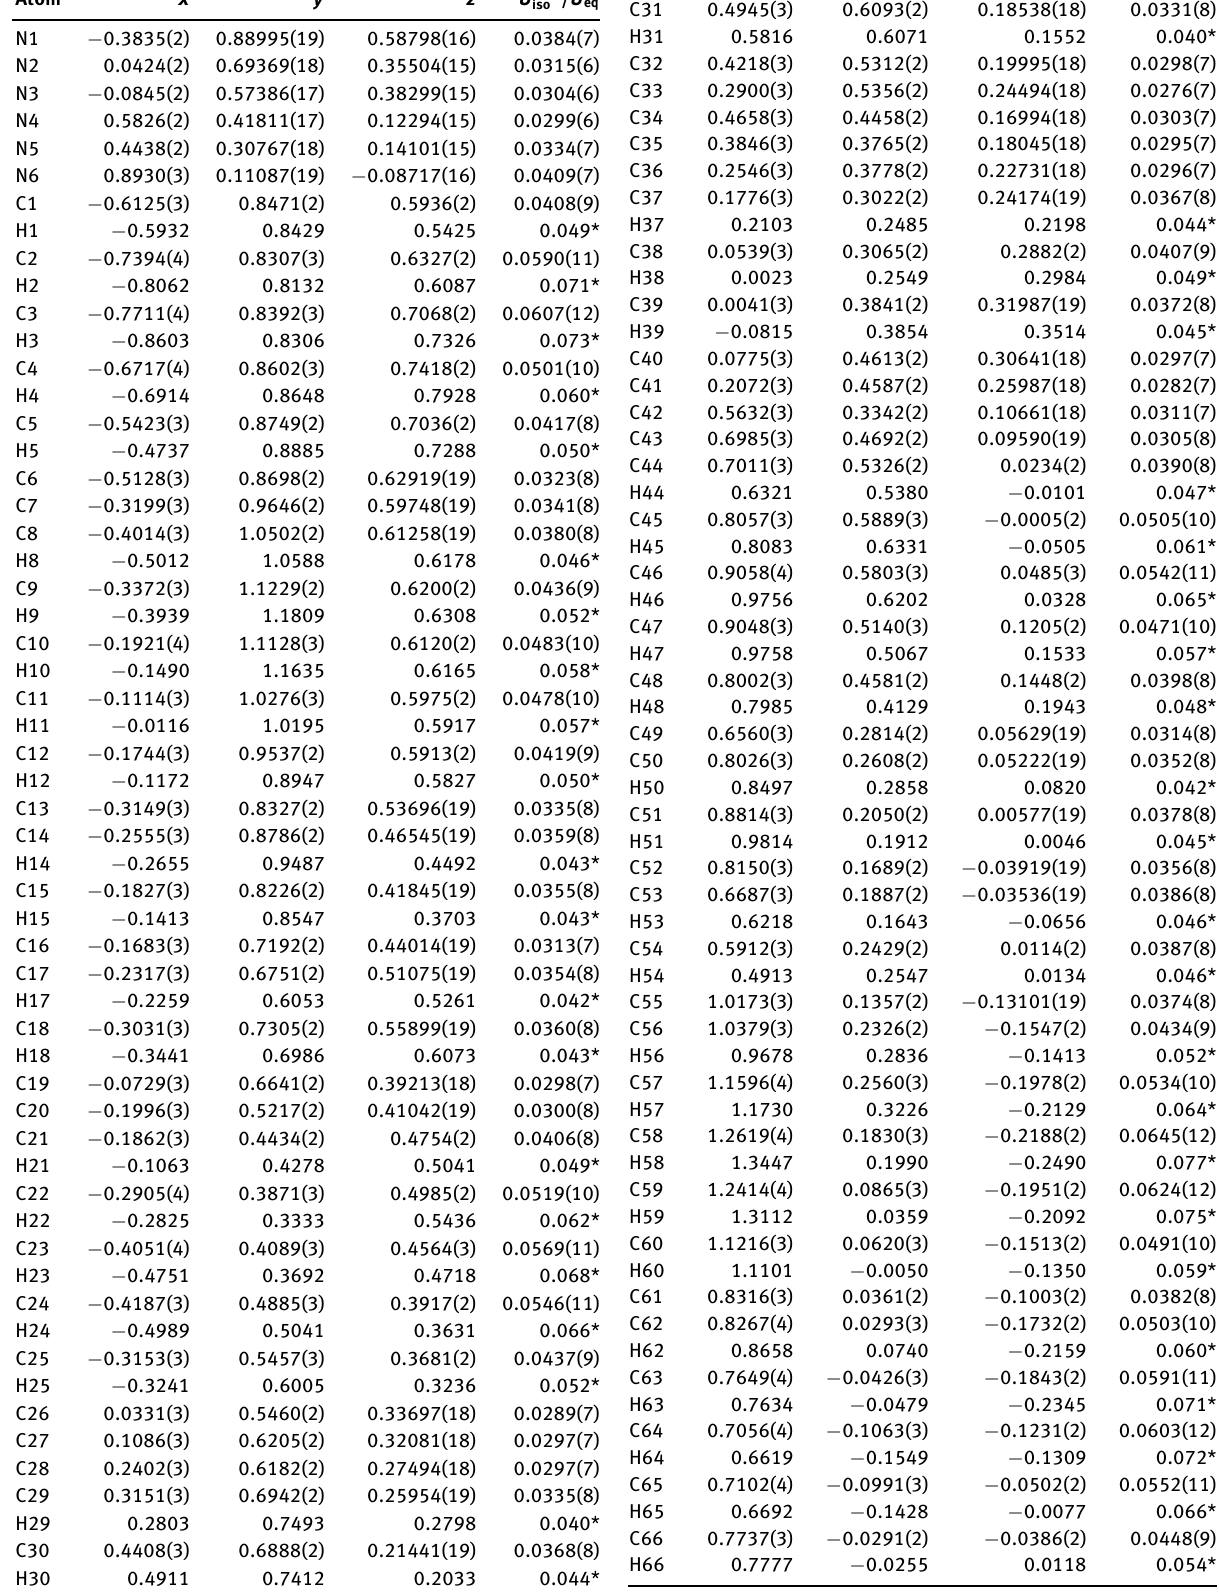
Table 2: Fractional atomic coordinates and isotropic or equivalent isotropic displacement parameters (Å 2